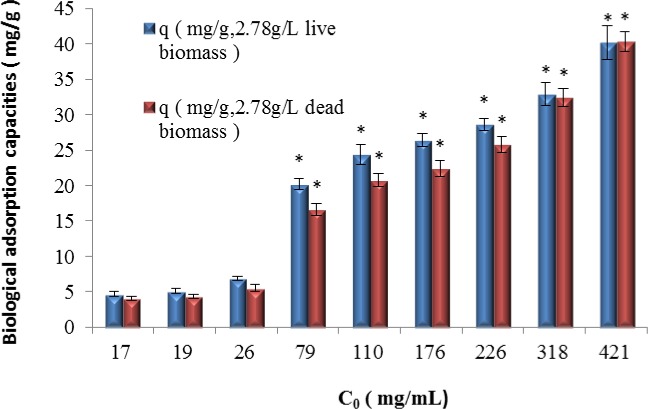
Biological adsorption capacities of the live and dead of the B. cereus S5 strain biomasses (*p<0.05,*based on the value of 17mg/LCd2+).